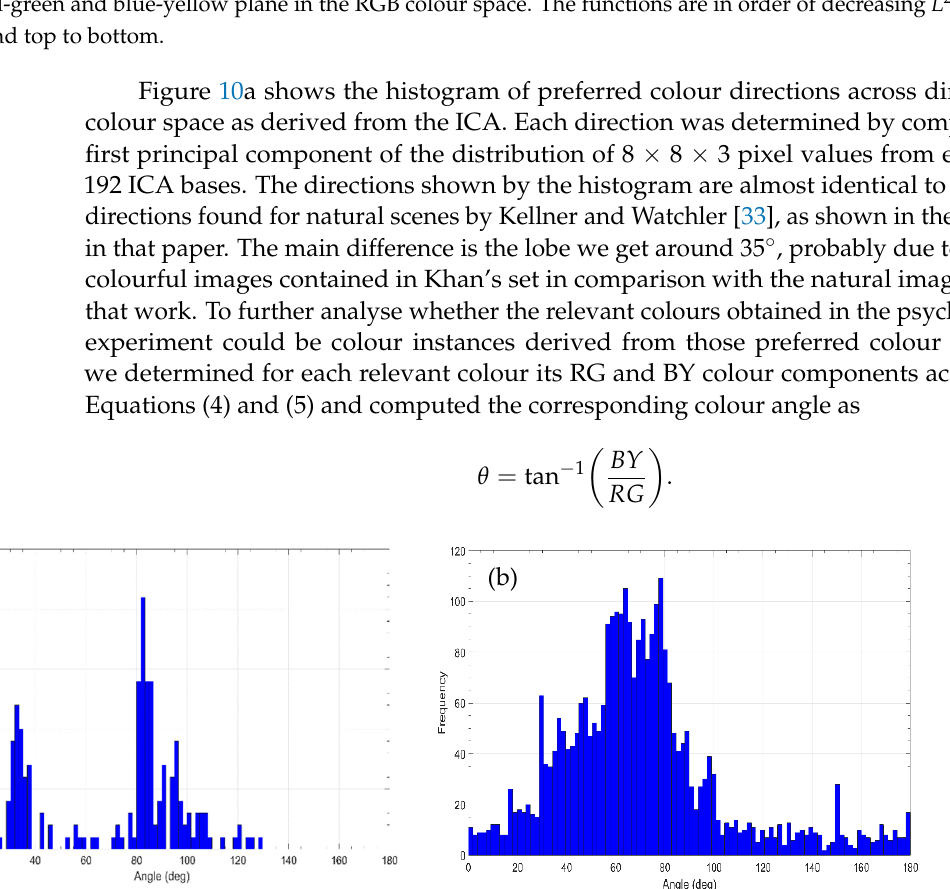
Figure 10. ( a ) Histogram of the distribution of chromatic directions associated to each ICA basis function using the Khan set of painting images. ( b ) Histogram of colour angles in the RG and BY colour plane obtained from the relevant colours and all observers used in the psychophysical experiment.